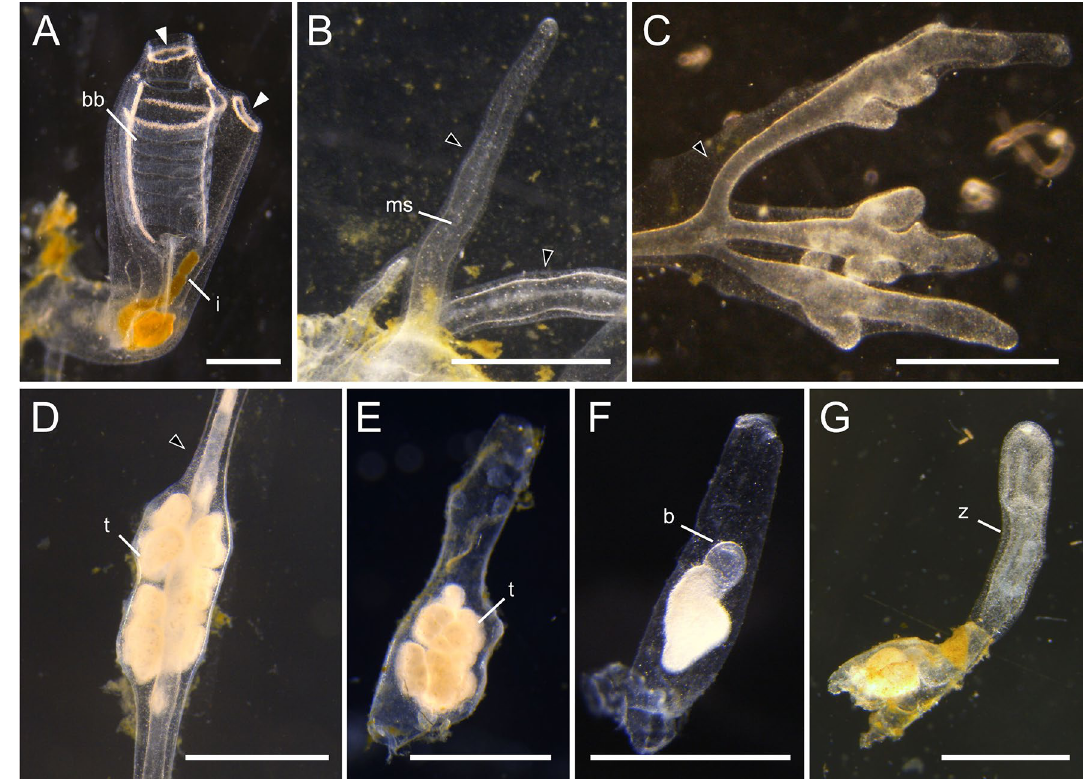
Figure 4. Photomicrographs of Clavelina lepadiformis asexual stages . ( A ) View of a feeding zooid with siphons (white arrowheads), branchial basket (“bb”), and intestine (“i”). ( B ) Stolons (marked with black arrowheads) protruding from zooid allow for attachment to substrate and for production of pre-buds. Mesenchymal septum (“ms”) indicated within stolon. ( C ) Stolons (marked with black arrowheads) undergo branching morphogenesis near the tips and begin to form the pre-buds (also called budding chambers in this species). ( D ) Early winter bud in a stolon still attached to the zooid. It has accumulated mass of trophocytes (“t”) inside as indicated by opaque white material. Stolon marked with white arrowhead. ( E ) Detached winter bud with a large mass of trophocytes (“t”). ( F ) Winter bud undergoing early steps of germination. The germinating bud (b) seen as a small transparent bump above the trophocyte mass. ( G ) Late germination stage showing young zooid (“z”) that arose from winter bud. Siphons are not yet visible. Remnants of winter bud remain and continue to supply nutrition to zooid until it begins to feed on its own or until it runs out of the supplied nutritive material. Scale bars are all 1 that the budding nests transferred to 8 °C, 12 °C, 17 °C could form spherules. When the spherules (collected in the field or produced in the laboratory, both stored at 10 °C) were transferred to lower temperatures (from 10 to 8 °C) they did not activate; however, when they were transferred to slightly higher temperatures (from 10 to 12 °C) germination was activated and new zooids were generated. We noted that spherule germination was days faster at higher temperatures, but was not synchronized across specimens. The ability to produce dormant forms under laboratory conditions was tested also in C. lepadiformis . Speci- mens of C. lepadiformis were collected at the same site as P. zorritensis and were cultured on glass slides at 18 °C. As previously described by other authors 32,35,37 the zooids emitted vascular stolons as prolongations of the postabdomen (Fig. 4B). The stolonal tip sometimes started to bulge forming one or more lobes, which looked more pale and whitish than the rest of the stolon (Fig. 4C). These structures represent the budding chambers, in which the budding process takes place once the hemocyte circulation is interrupted between the zooid and the budding chamber. At this temperature, other structures similar to budding chambers but more compact and whitish are produced along the stolon; they represent the winter buds, which are able to resist cold temperature according to other authors (Fig. 4D 39,41 ). Our results showed that the production of C. lepadiformis dormant forms, the winter buds, occurred at 18 °C in laboratory conditions; and that similarly to budding chambers, the winter buds could be activated by isolation from the stolon. According to the above-mentioned authors, the milky coloration of winter buds is due to accumulation of trophocytes, i.e., hemocytes specialized for storage and transport of nutrients. Viability and range of resistance of P. zorritensis spherules and C. lepadiformis winter buds. In order to determine the ability of dormant forms to resist sudden environmental changes, we exposed spherules and adult zooids of P. zorritensis to abrupt shifts in temperature (− 20 °C to 37 °C) and salinity (10–44 ppt) for